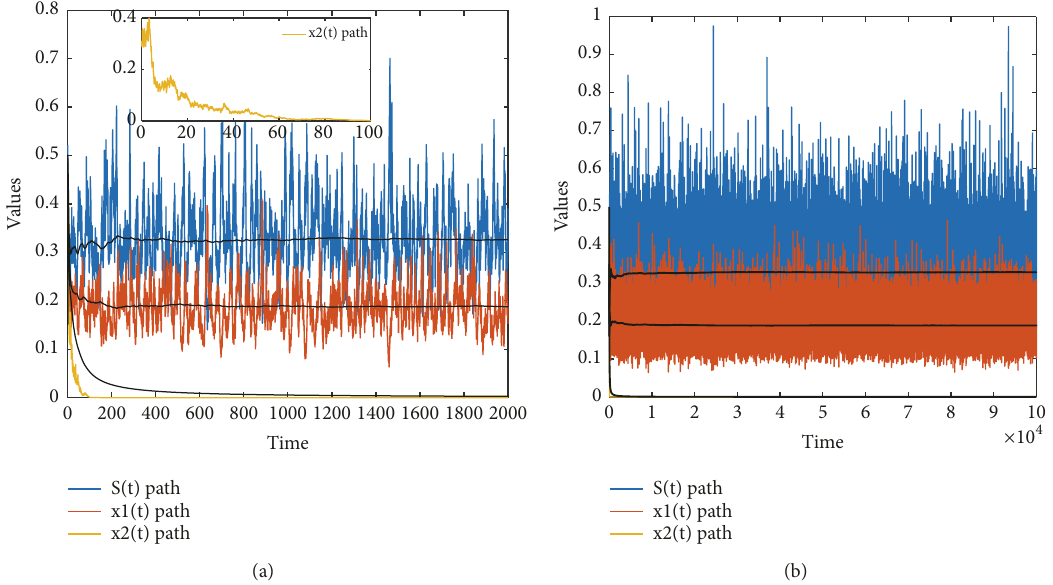
Figure 1: 𝑥 1 survive and 𝑥 2 will be extinct for system (116) with initial value 𝑆(0) = 0.5 , 𝑥 1 (0) = 𝑥 2 (0) = 0.3 . (a) and (b) are the time series of system with different time scale.